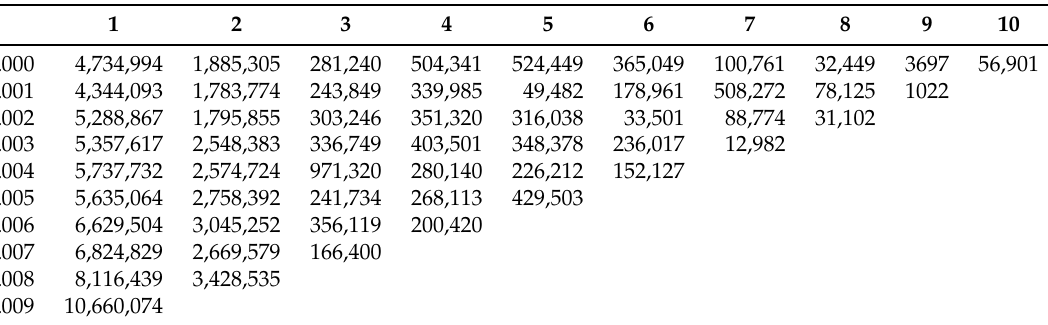
Table 2. Full run-off triangle for paid out